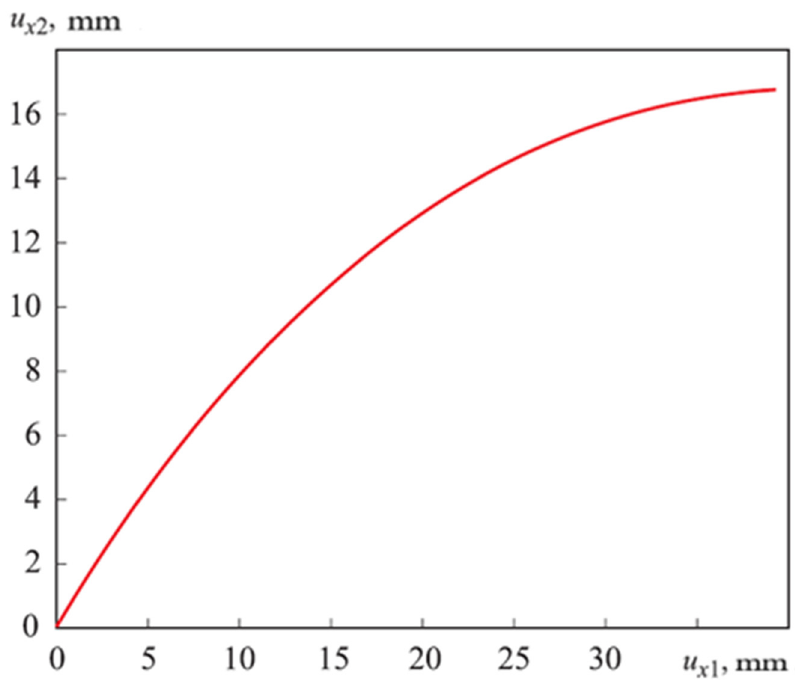
Figure 9. Nonlinear elastic characteristic longitudinal–transverse transducer.